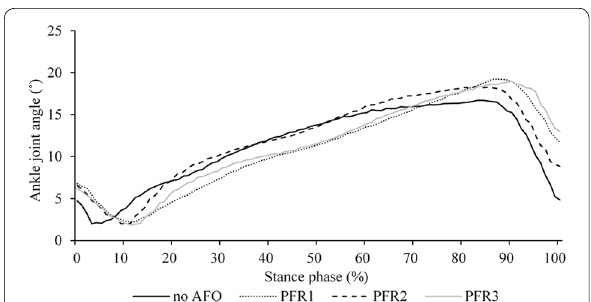
Fig. 3 Ankle joint angle in stance phase. Dorsiflexion is defined as positive. The % stance phase means time normalized to stance phase, from heel contact to toe